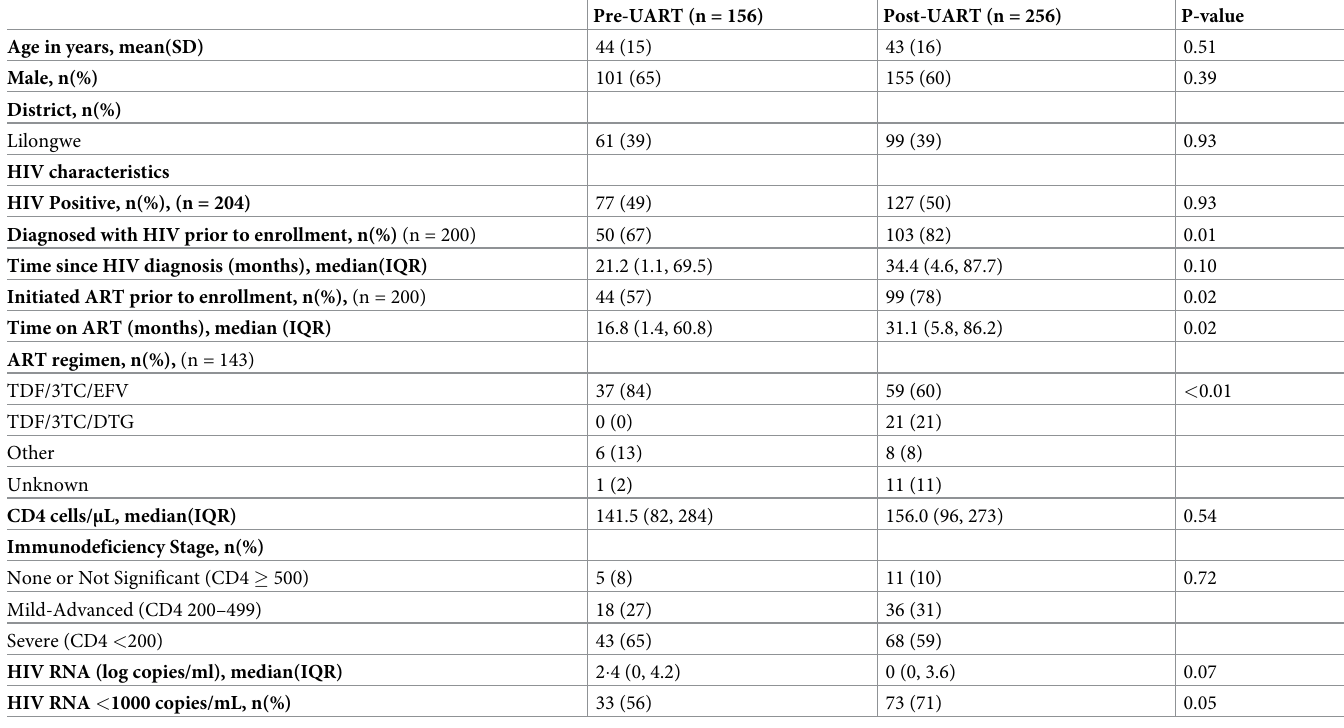
Table 1. Baseline characteristics of the study population by pre- and post-universal ART groups.